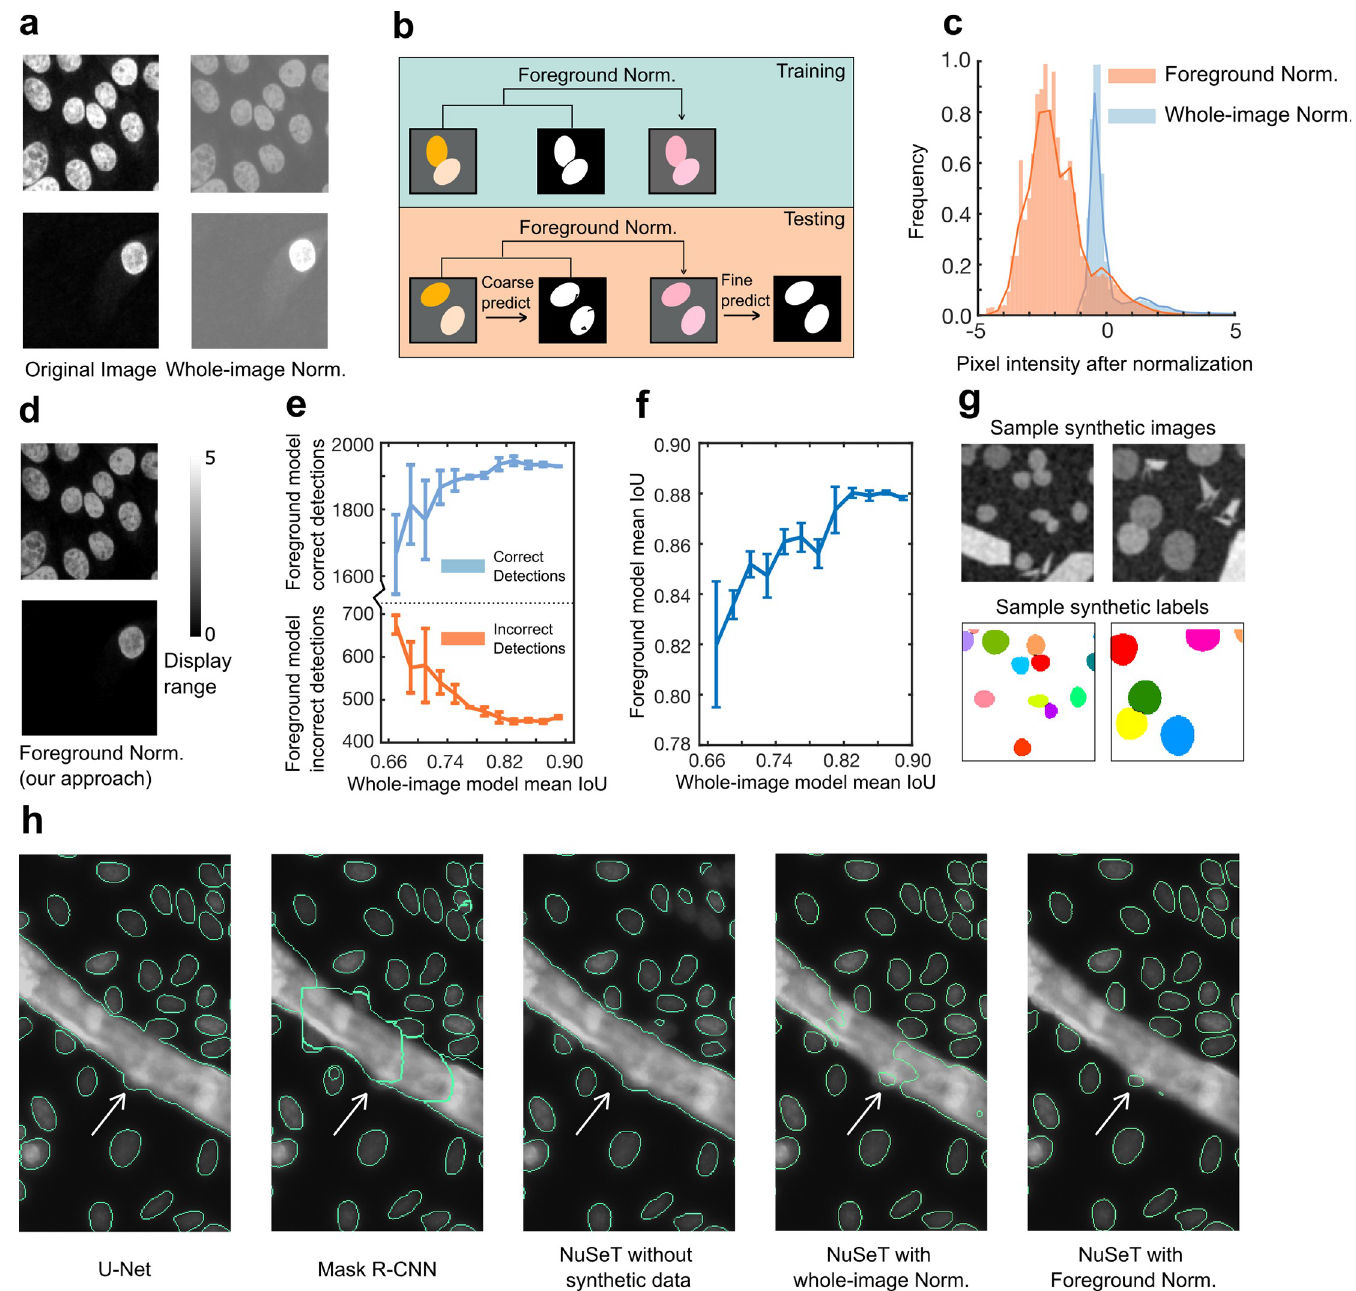
Fig 2. Improved normalization performance by foreground normalization and synthetic training. (A) The visual effects of normalizing sparse/dense samples using whole-image normalization showing images having inconsistent nuclear signals after normalization. (B) Foreground normalization during training and testing. During training, only pixels belonging to cell nuclei are used to normalize the image. During testing, a coarse segmentation prediction is generated by the model, and pixels belonging to the predicted nuclei are used to perform foreground normalization. The model then makes final predictions based on the normalized input images. (C) Distribution of pixel intensities over an entire training dataset after different normalizations, showing foreground normalization has wider dynamic range. (D) The visual effects of normalizing sparse/dense samples using foreground normalization showing images have a higher dynamic range and more consistent nuclear signals. (E, F) Line charts showing that the object-level performance (E) and the pixel-level performance (F) of the foreground normalization model depend on the pixel-level performance of the whole-image normalization model. Error bars represent three individual experiments. (G) Examples of synthetic images with labels used during training. Our algorithm can generate synthetic nuclei-shaped blobs with different sizes, as well as different types of artifacts to increase the robustness of the model. Overlapping nuclei were introduced to enhance NuSeT performance in touching nuclei separation. (H) Representative examples comparing the performances of different segmentation approaches. Training without synthetic images mis-identified artifacts (stripes) as foreground. The addition of synthetic data improved artifact detection. Switching to foreground normalization led the best performance including robust identification of imaging artifact, detected of more nuclei, and better separation of touching nuclei compared to Mask R-CNN and